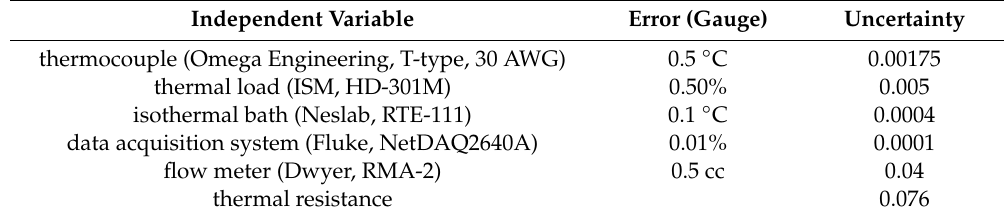
Table 2. Uncertainties of the experimental setup for the LHP System in this